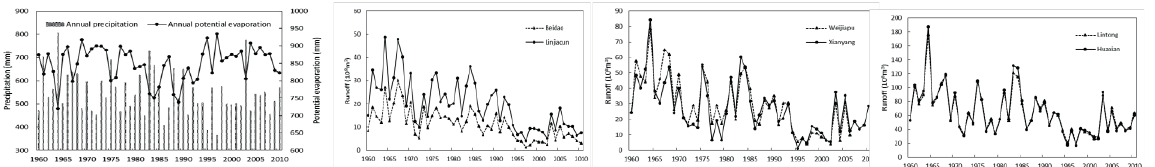
Fig. 2 Area annual precipitation (mm) , area potential evaporation (mm), annual runoff (10 8 m³) in the Weihe